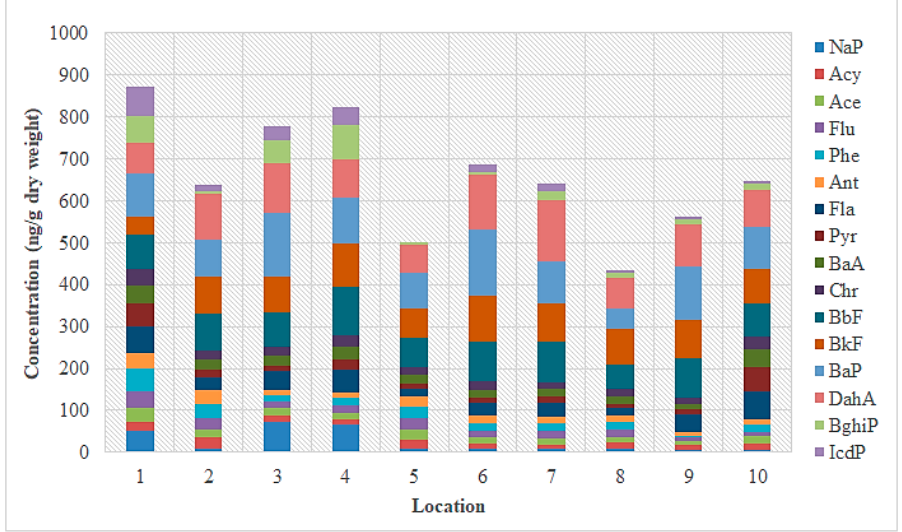
Figure 9. Concentrations of the 16 priority PAHs (ng/g dry weight) found in sediment samples from the Volturno River at 10 sampling locations (April 2018).